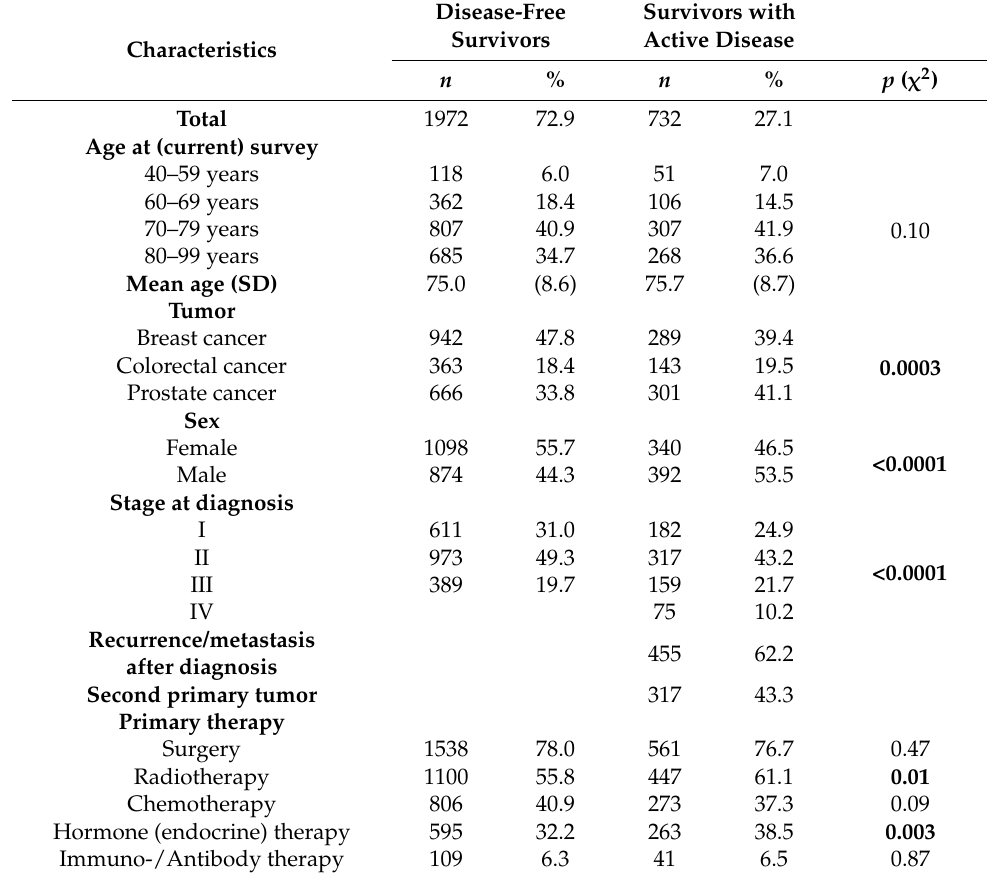
Table 2. Characteristics of very long-term cancer survivors and disease-free survivors versus sur- vivors with stage IV at diagnosis or with subsequent recurrence, metastasis, or second cancer (active